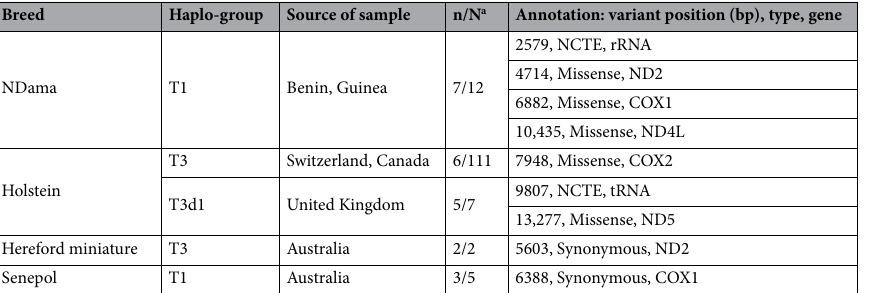
Breed Haplo-group Source of sample n/N a Annotation: variant position (bp), type,